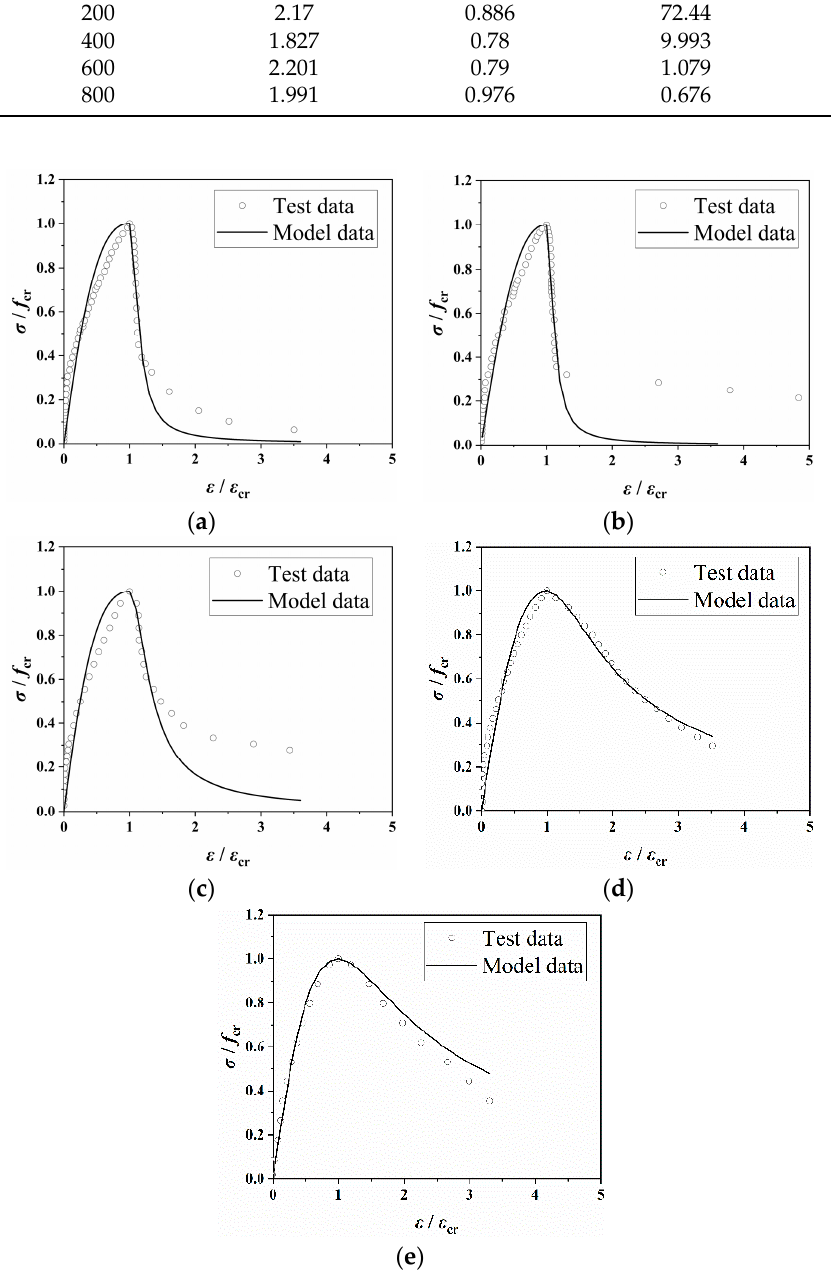
Figure 15. Comparison between calculated and tested curves of HPLWC after different temperatures: ( a ) Ambient tem- perature, ( b ) 200 °C, ( c ) 400 °C, ( d ) 600 °C, ( e ) 800 °C.